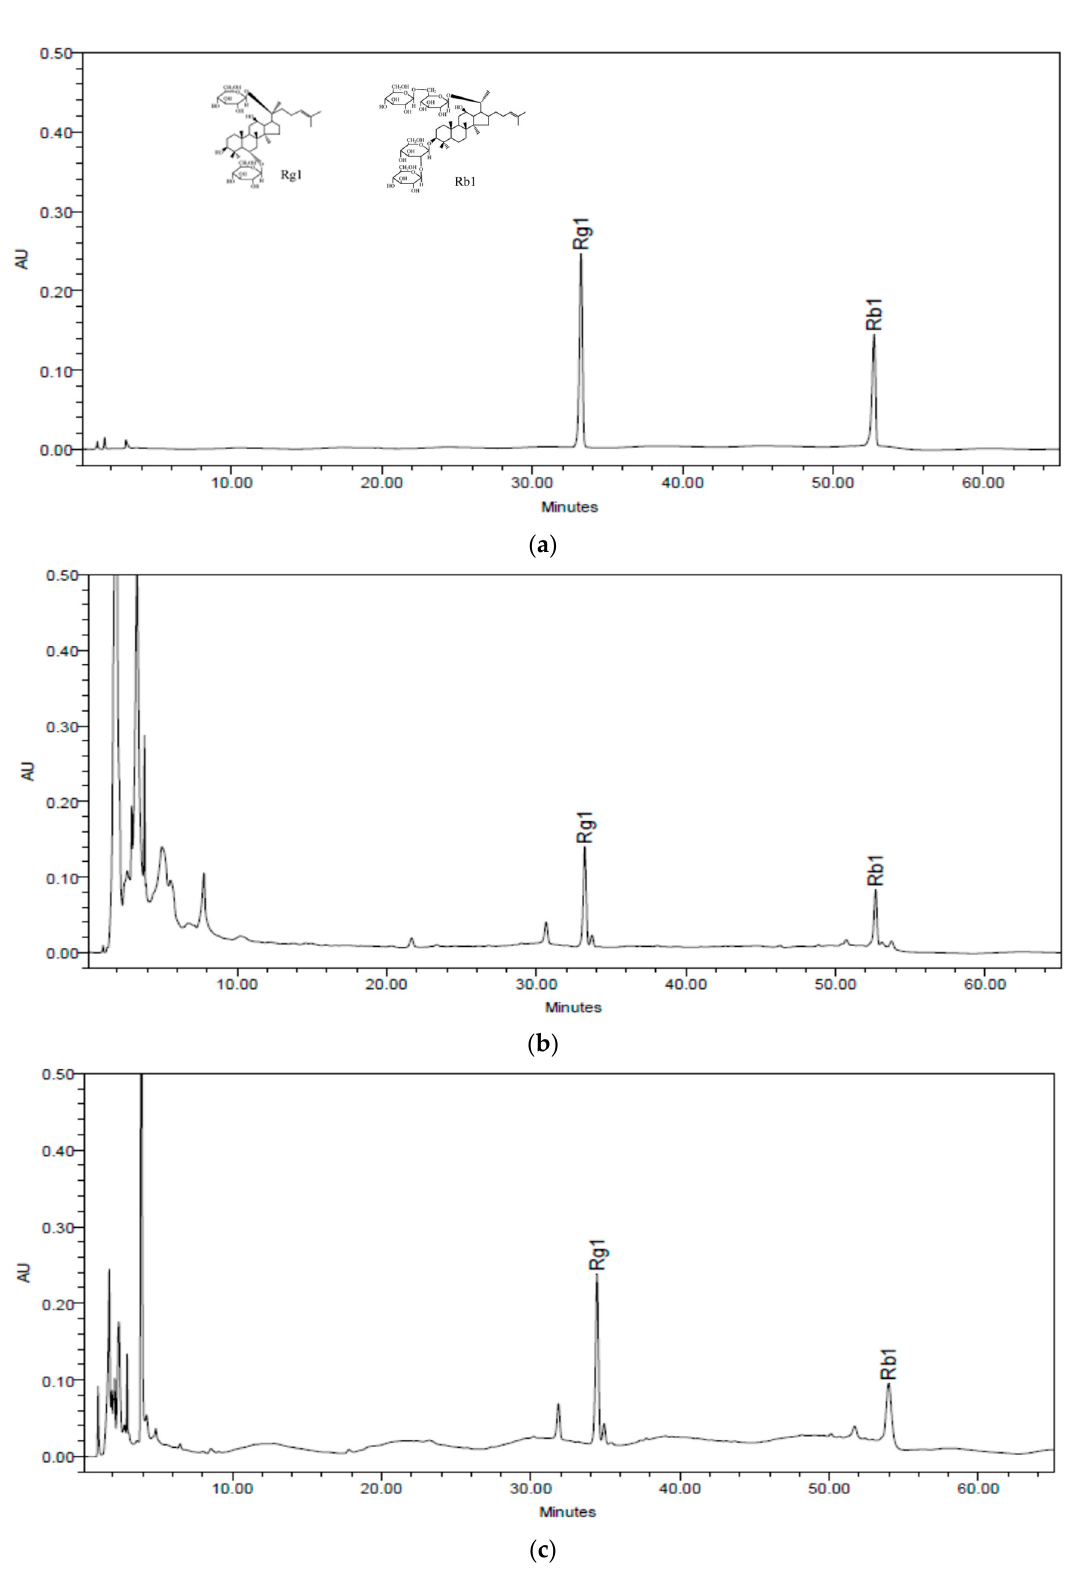
Figure 2. HPLC chromatogram of ginsenoside Rg1 and Rb1. ( a ) Standard mixture of ginsenoside Rg1 and Rb1. ( b ) Cardiotonic pills contained 0.36% of ginsenoside Rg1 and 0.34% of Rb1. ( c ) Sample B contained 0.83% of ginsenoside Rg1 and 0.95% of